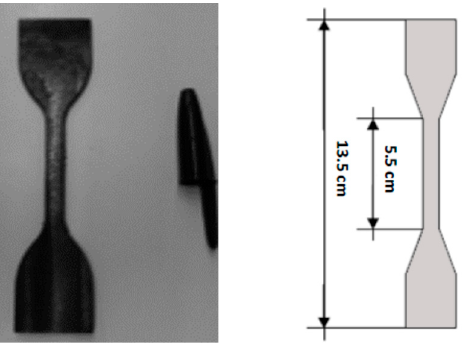
Figure 1. Obtained samples for testing. Depth sample of 2.5 mm. L 0 = 55 mm. Width = 5 mm.